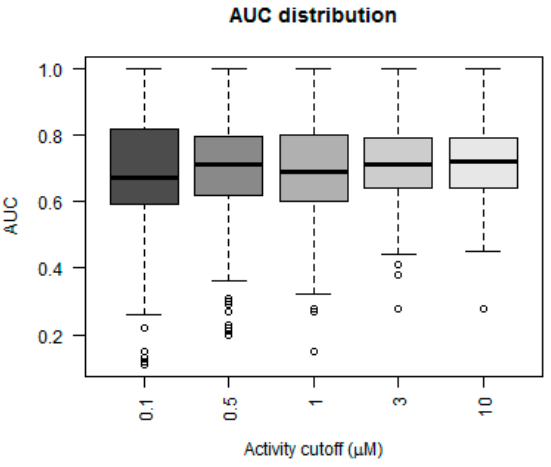
Figure 3. Area under curve distribution. Box plot showing the performance of the five models using distribution of area under the curve (AUC) values for individual kinases. The five models have been generated using activity values specified at different cutoffs as indicated on the x-axis. The upper and lower edges of the box correspond to the first and third quartiles. The horizontal dash in the box represents the median value. The whiskers extend from the edge to the highest/lowest value within the 1.5× interquartile (IQR) of the box, where the IQR is the distance between the first and third quartile.